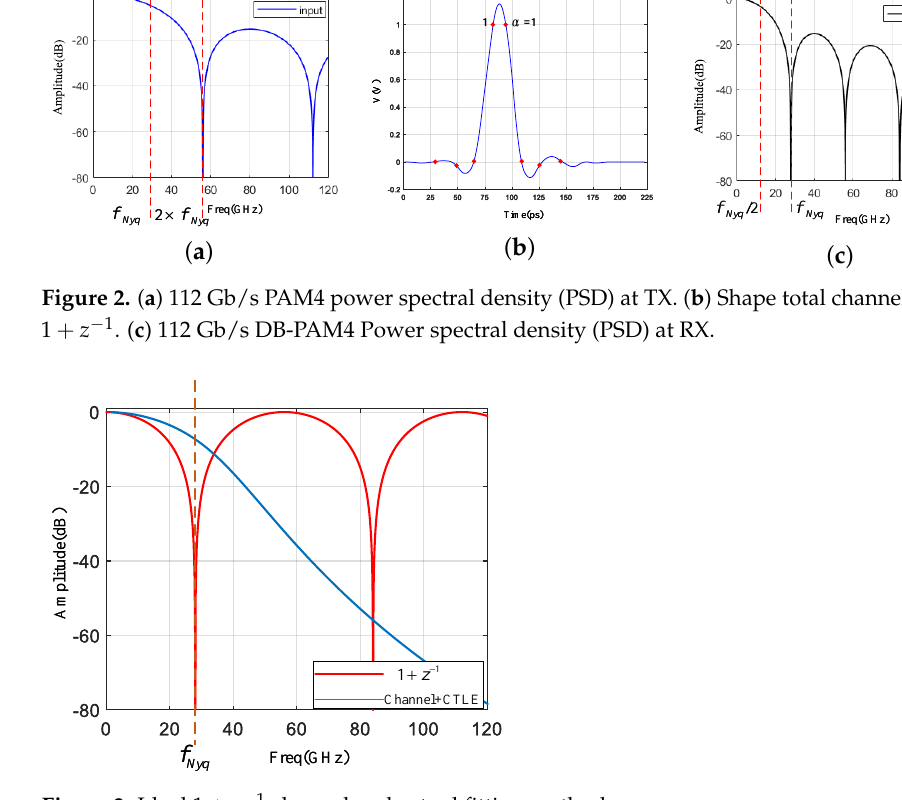
Figure 3. Ideal 1 + z − 1 channel and actual fitting method.